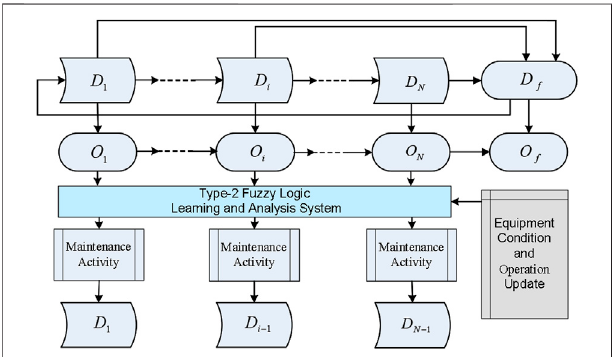
FIGURE 2 | Type 2 fuzzy hidden Markov